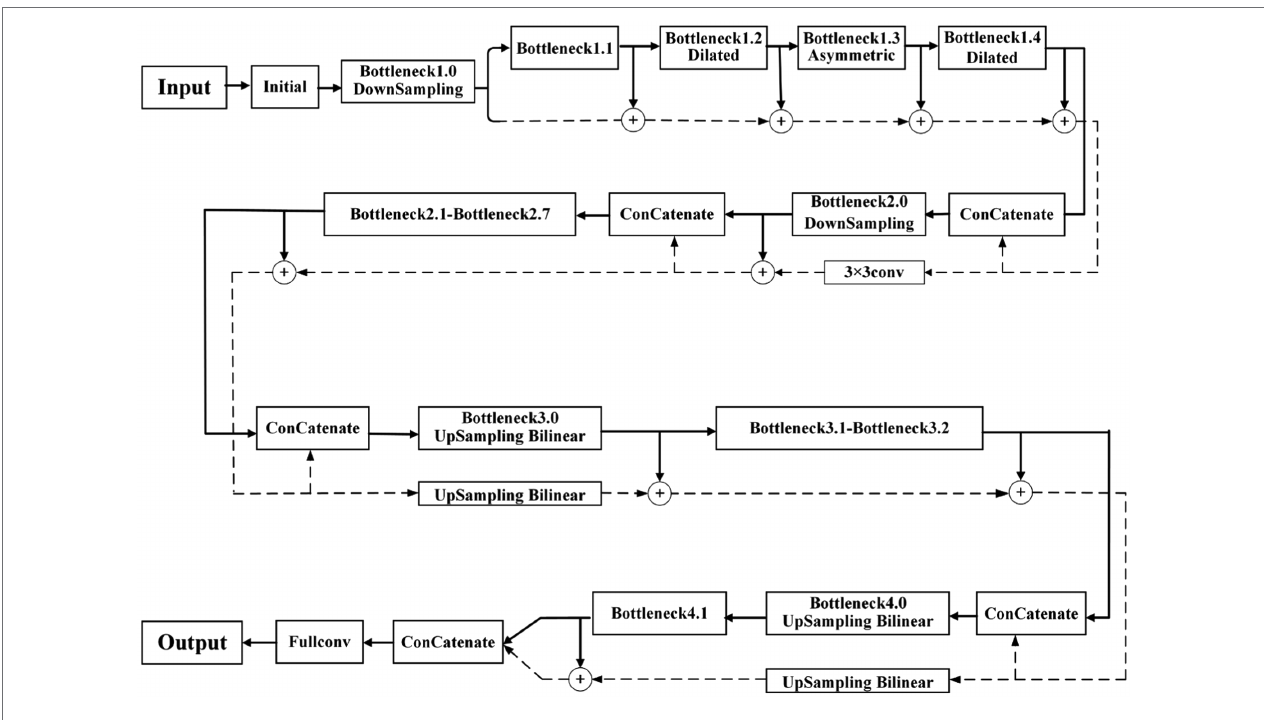
FIGURE 2 | The improved ENet